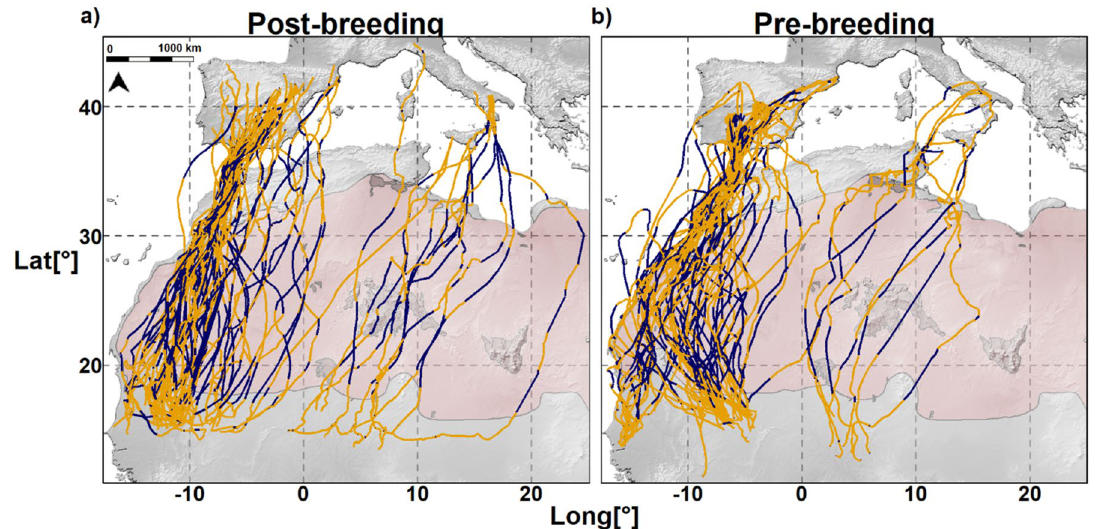
Figure 1. Migration routes of lesser kestrels tracked with GPS between 2014 and 2019. ( a ) Post-breeding and ( b ) pre-breeding migration. Colours indicate nocturnal migration (blue segments) and diurnal migration (orange segments) when flying over non-barriers (grey) or barriers (desert =pink, sea = white). One position per hour was plotted.